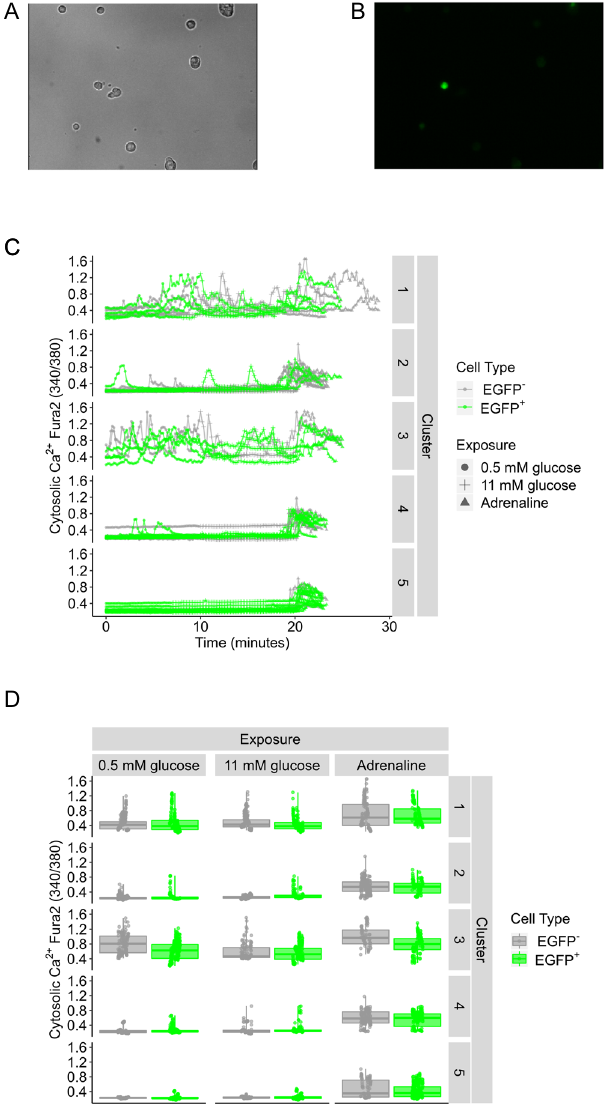
Figure 4. Intracellular Ca 2 + pattern in EGFP positive and EGFP negative α -cells in response to glucose and adrenaline. ( A ) Bright field and ( B ) fluorescent EGFP signals in dispersed islet cells. ( C ) Raw Ca 2 + traces from single EGFP + (green) and EGFP − (grey) α -cells in response to low glucose (0.5 mM), high glucose (11 mM) and adrenaline (5 µ M). ( D ) Summary statistics for the cell types sorted by cluster. A total of 33 EGFP + and 27 EGFP − α -cells from 5 AAV-treated mice were